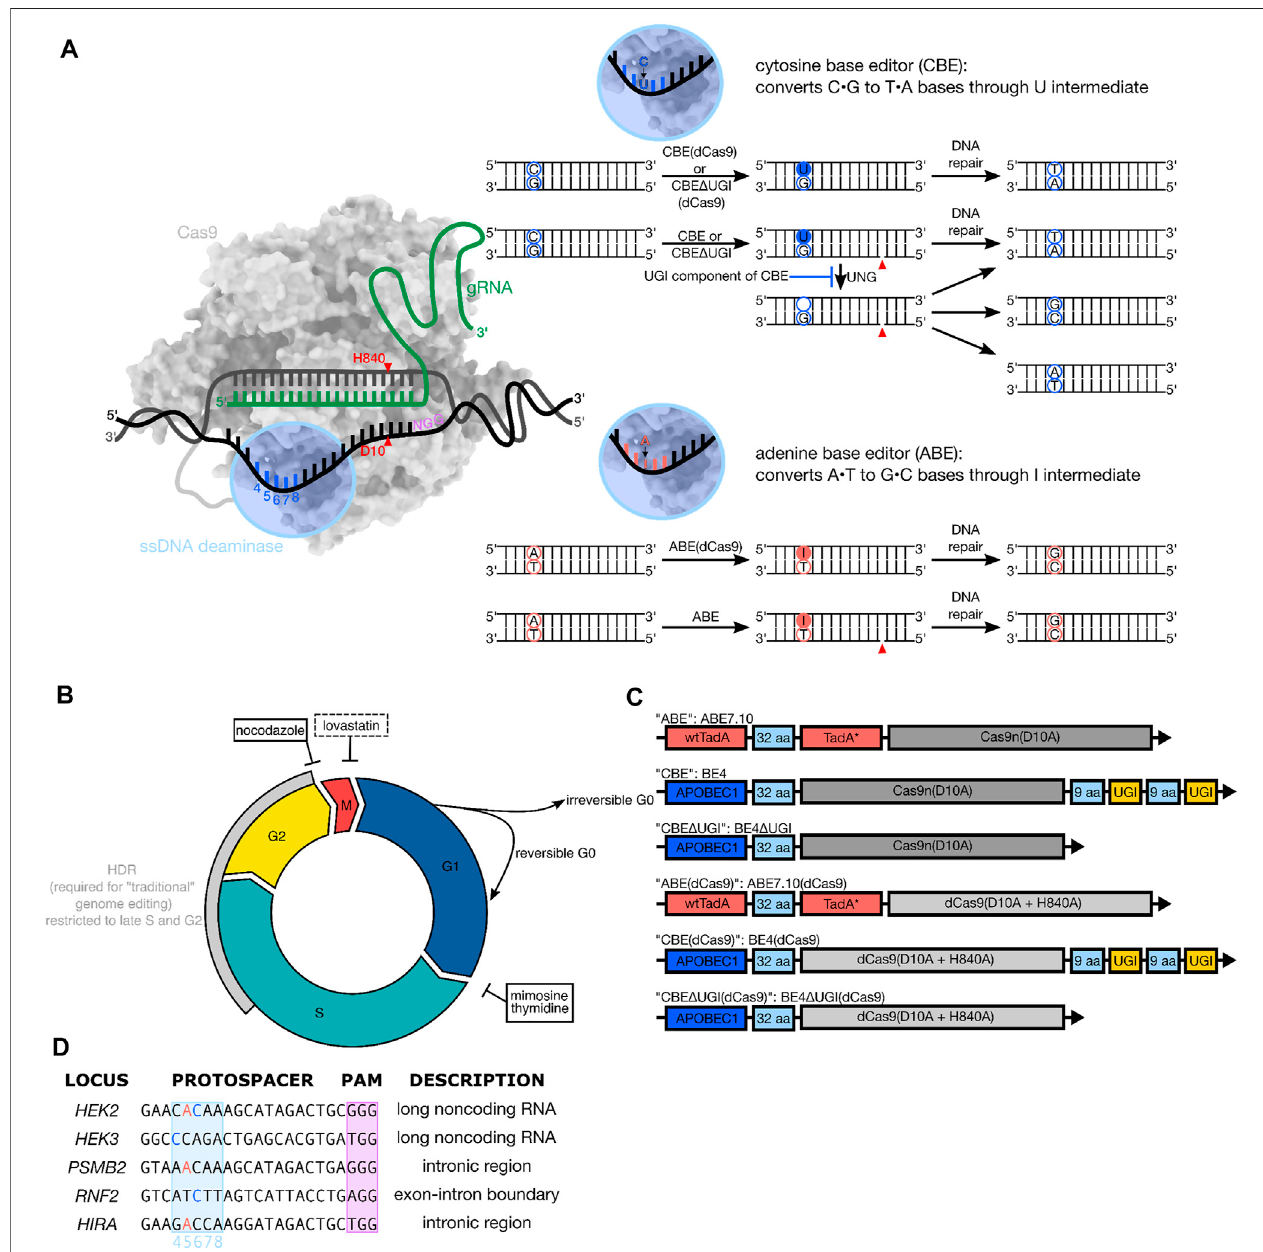
FIGURE 1 | (A) Overview of base editing. Base editors consist of a ssDNA modifying enzyme (blue) covalently tethered to a catalytically inactive or impaired Cas9 (dCas9 or Cas9n) protein (grey). The base editor binds to a genomic locus of interest via protospacer adjacent motif (PAM, shown in purple) recognition and Watson- Crick-Franklin base pairing between the gRNA and the protospacer. Local denaturation of the DNA during R-loop formation exposes ~5 nucleotides (protospacer positions4 – 8)tothessDNAmodifyingenzyme,whichwilldeaminate thetargetbasetotheUorIintermediate.Themodi fi edbasewillgetpermanentlyconvertedto a canonical base pair following cellular replication or repair across thelesion. (B) Overview ofthe phases ofthecell cycle. Precision genomeediting using wild-type Cas9 uses homology directed repair, which is highly cell cycle dependent (grey arc) and usually outcompeted by the error-prone non-homologous end joining pathway. Base editing has been demonstrated to be effective in terminally differentiated cells, suggesting its reliance on non-cell-cycle-dependent DNA repair pathways. The chemical synchronizationagentsusedinthisstudy(nocodazole,mimosine,andthymidine)areindicatedinblackboxeswithinhibitoryarrowspointingtothephaseofthecellcycle in which they arrest cells. Additionally, the synchronization agent lovastatin, which was used in initial synchronization experiments but not in base editing experiments, is indicated in a black dashed box. (C) Architecture of constructs used. All constructs employ the Streptococcus pyogenes (Sp) Cas9 homolog. All ABEs are single polypeptidechainsconsistingofthreefusedprotein components — awild-type Escherichiacoli ( E.coli )TadA(tRNA-speci fi cadenosinedeaminase),alaboratoryevolved E.coli TadA(TadA*)thatcatalyzes deoxyadenosinedeamination,and animpaired (Cas9n)orinactive (dCas9) Cas9. AllCBEsareasingleprotein fusionconsisting ofthe rat APOBEC cytidine deaminase enzyme (APOBEC1) tethered to Cas9n or dCas9, followed by two copies of uracil glycosylase inhibitor (UGI) – except in the case of the CBE Δ UGI constructs. (D) Protospacers and PAM (purple) sequences of the genomic loci studied, with target Cs (blue) and As (salmon) within the base editing window (protospacer positions 4 – 8, light blue)